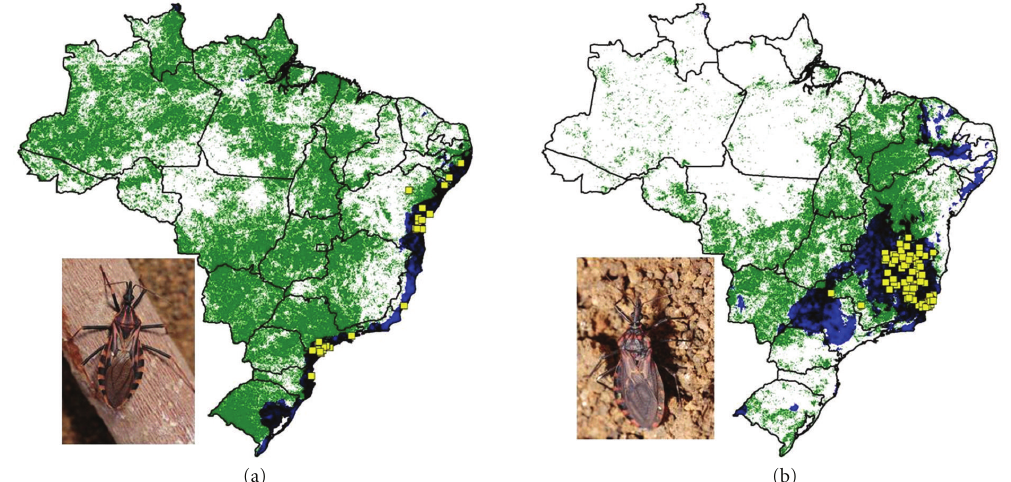
Figure 7: Ecological niche models projected as potential distributions for Atlantic Forest triatomine species. (a) T. tibiamaculata and (b) T. vitticeps .